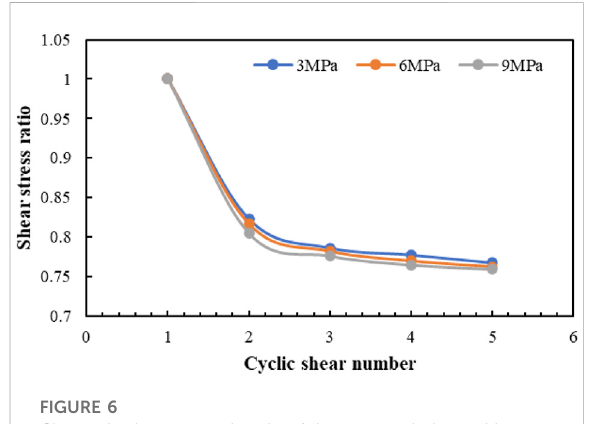
FIGURE 8 Stress diagram of a bedding rock sliding mass under a horizontal